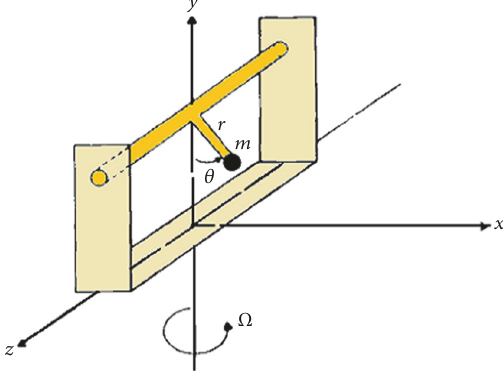
Figure 4: A simple pendulum attached to a rotating rigid frame.